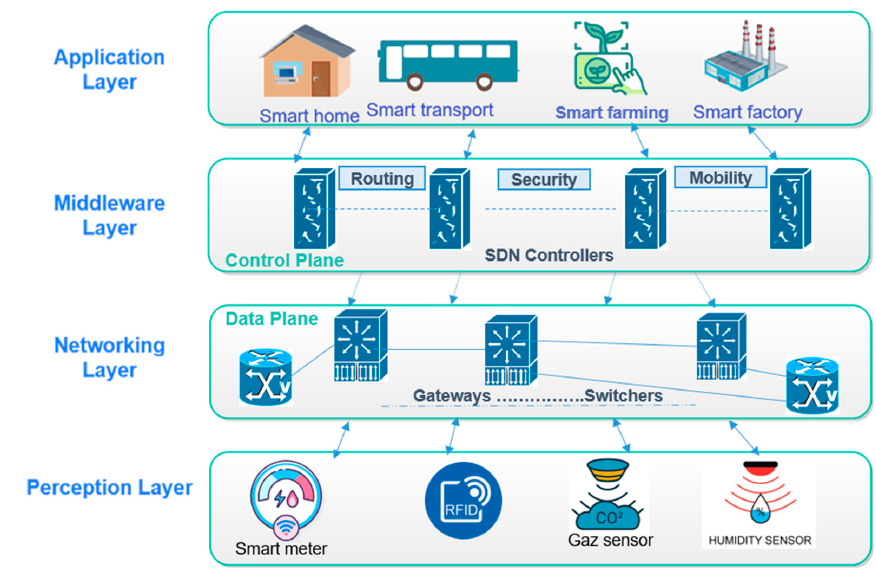
Figure 1. IoT layered architecture adapted to SDN.